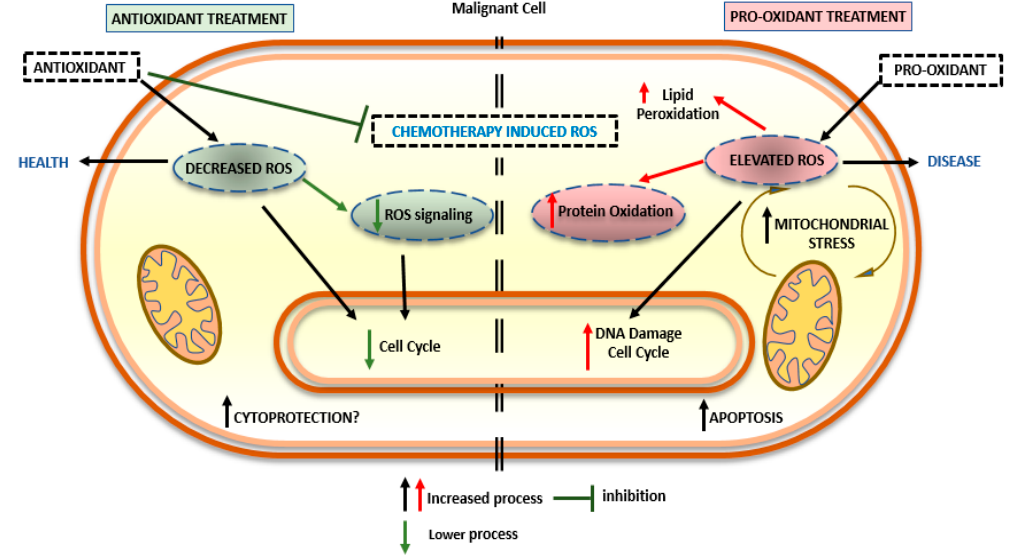
Figure 3. Antioxidant treatment versus pro-oxidant treatment during